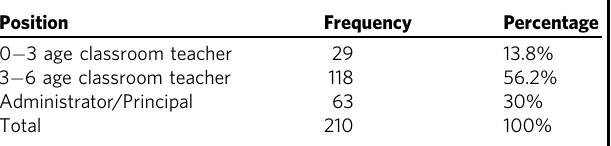
Table 1 Job positions of respondents ( n = 210).